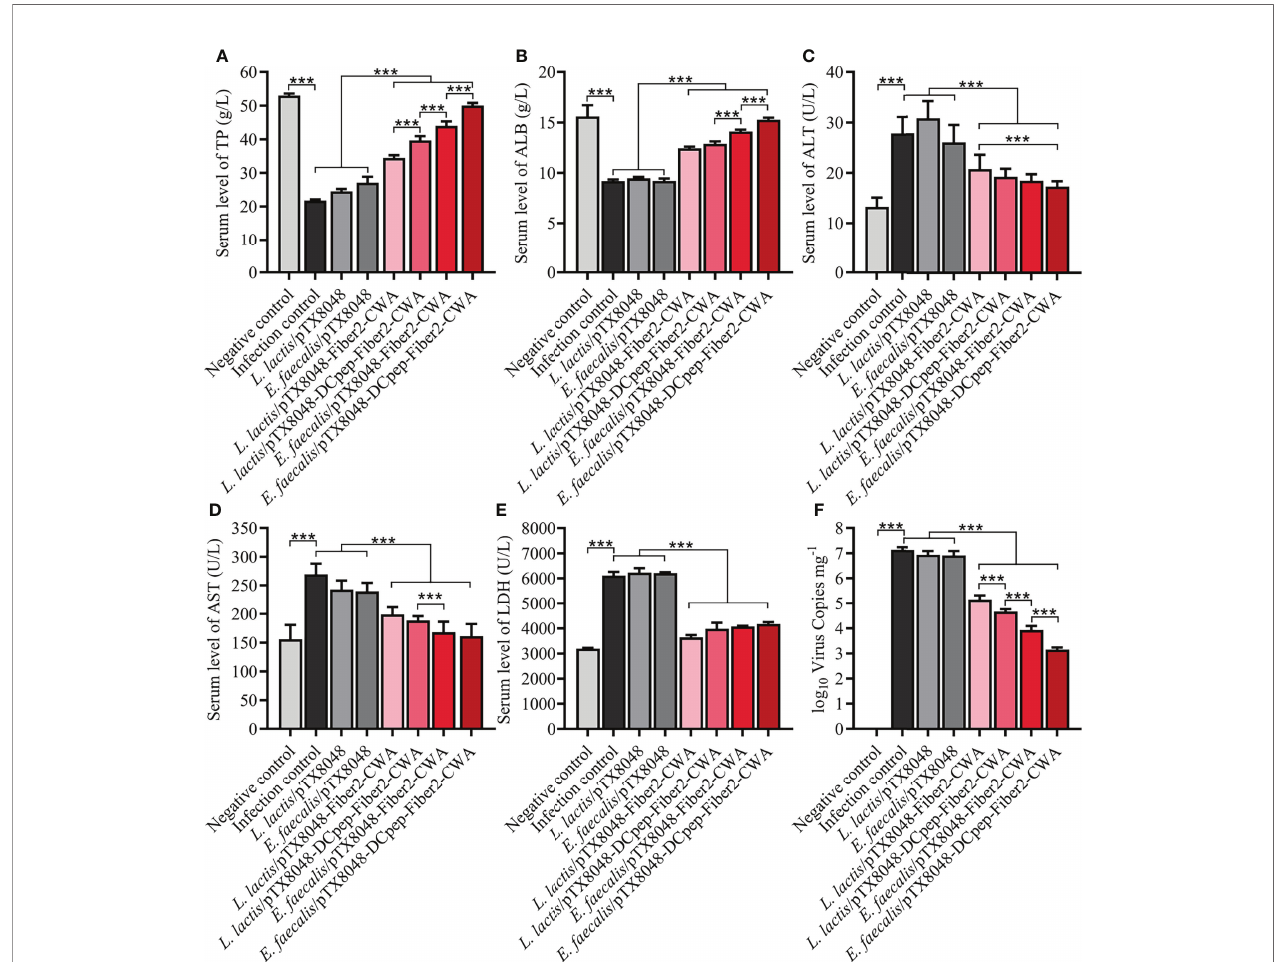
FIGURE 8 | Determination of alanine transaminase (ALT), aspartate aminotransferase (AST), lactate dehydrogenase (LDH), albumin (ALB), and total protein (TP) in sera. At 5 dpi, levels of liver function indexes including TP (A) , ALB (B) , ALT (C) , AST (D), and LDH (E) in sera of chickens (n = 5) from each group were detected using the purchased kit (Nanjing Jiancheng Bioengineering Institute) referencing provided protocols. At 5 dpi, liver tissues were collected from chickens in each group, and total DNA was extracted using a DNA extraction kit (Takara, Beijing, China). A standard curve was established based on the pMD-18T-52K plasmid. Real-time PCR was used to detect numbers of FAdV DNA copies in livers (F) . Each value represents mean ± SD. *** p <